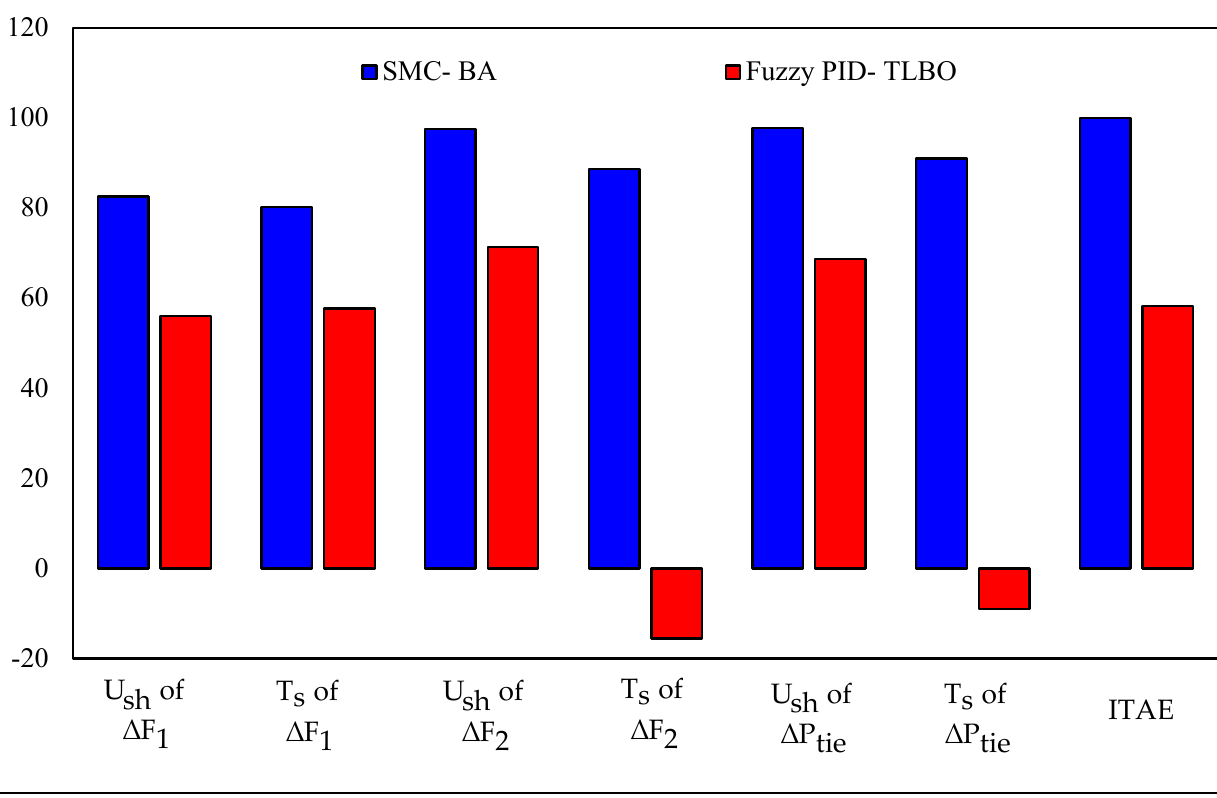
Figure 6. Percentage of improvement in undershoot, settling time and ITAE with different controllers.